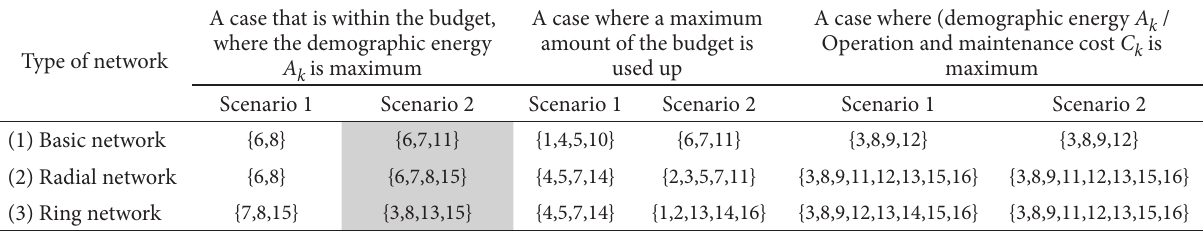
Table 9. Bridge decommission pattern of each network type